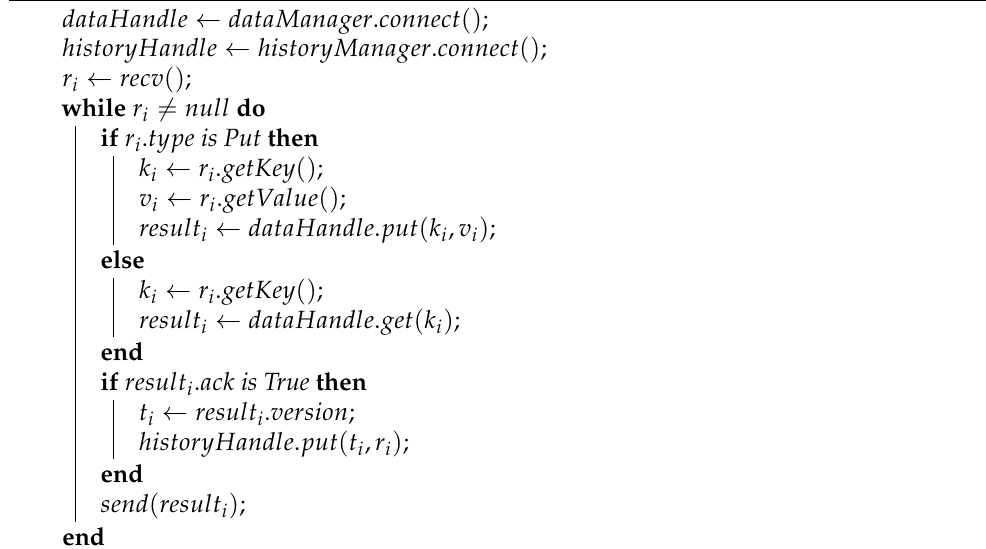
Algorithm 1: Relief Controller’s Request Handling